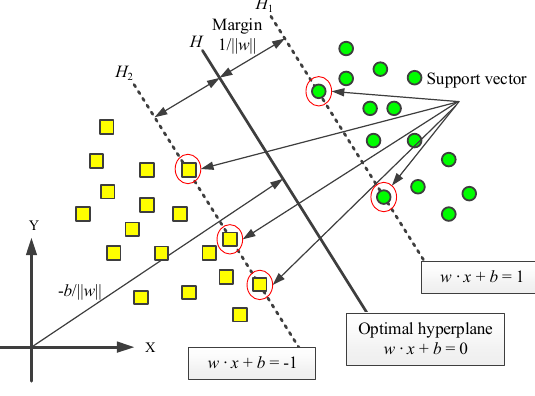
Figure 6. SVM for linear classification.